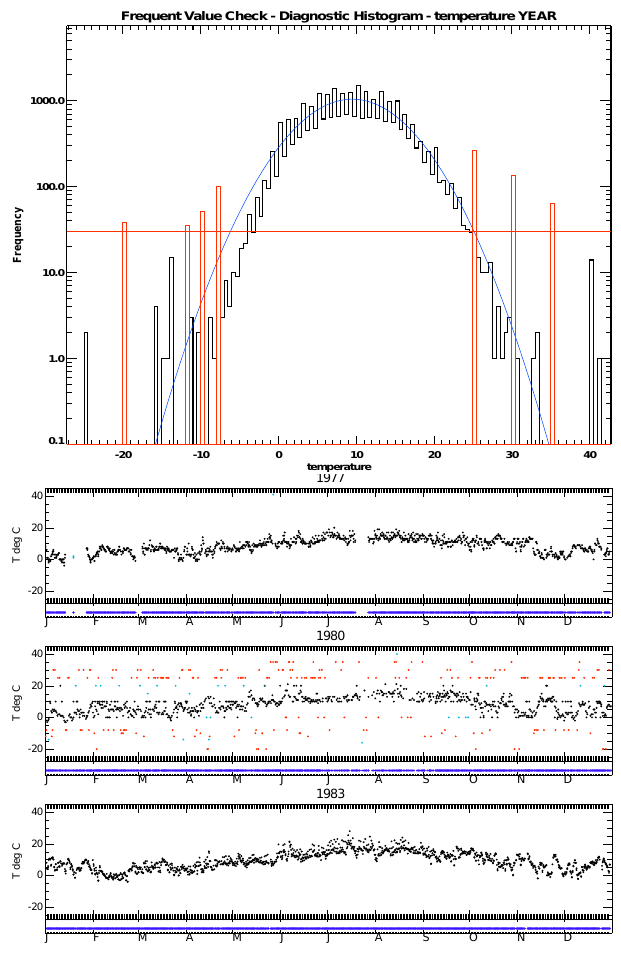
Fig. 4. Frequent value check (test 4) for station 037930-99999, Anvil Green, Kent, UK (51.22 ◦ N, 1.000 ◦ E, 140m), showing tem- perature. Top: Histogram with logarithmic y-axis for entire station record showing the bins which have been identified as being likely frequent values. Bottom: red points show values removed by this test and blue points by other tests for the years 1977, 1980 and 1983. The panel below each year indicates which station the ob- servations come from in the case of a composite (not relevant here but is relevant in other station plots so included in all).